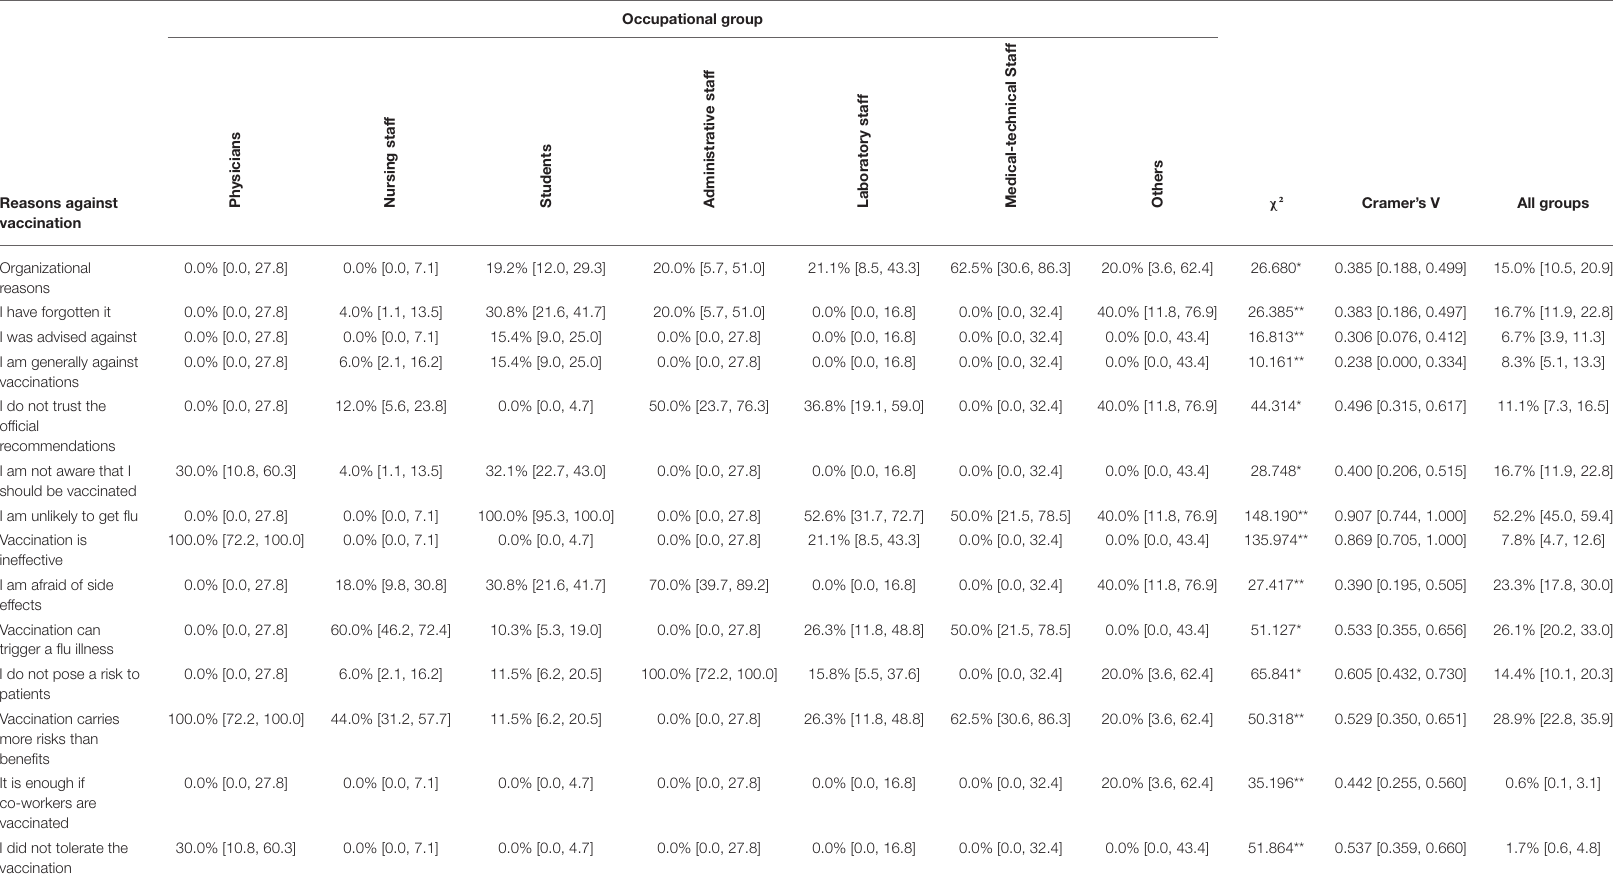
TABLE 4 | Relative frequencies, χ 2 -Test, and effect size (Cramer’s V) of the stochastic relationship between different reasons against vaccination and the occupational group. Occupational